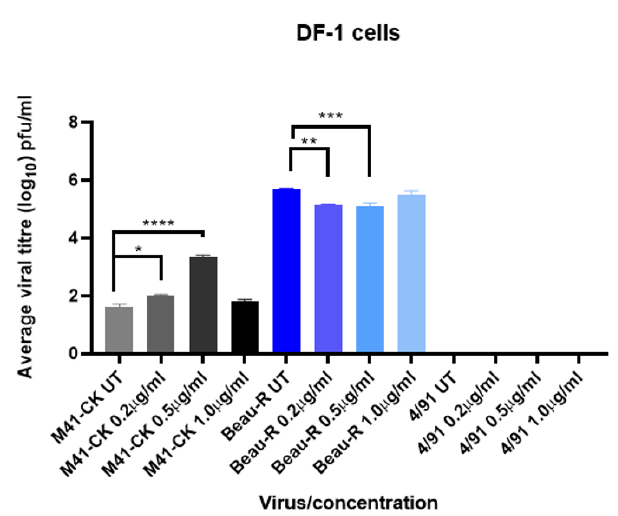
Figure 5. IBV replication in DF-1 cells is affected by trypsin. DF-1 cells were infected with IBV strains M41-CK, Beau-R or 4/91 (MOI = 0.1) diluted in BES medium either untreated (UT) or containing TPCK-treated trypsin at concentrations 0.2, 0.5 and 1.0 µg/mL. Supernatant was harvested at 24 hpi and titrated on CK cells in triplicate. Average viral titres are displayed with SEM. Statistical differences were calculated by One-Way ANOVA followed by Tukey’s multiple comparison test and are indicated for each strain. * indicates p < 0.02, ** indicates p < 0.01, *** indicates p < 0.001 and **** indicates p < 0.0001.